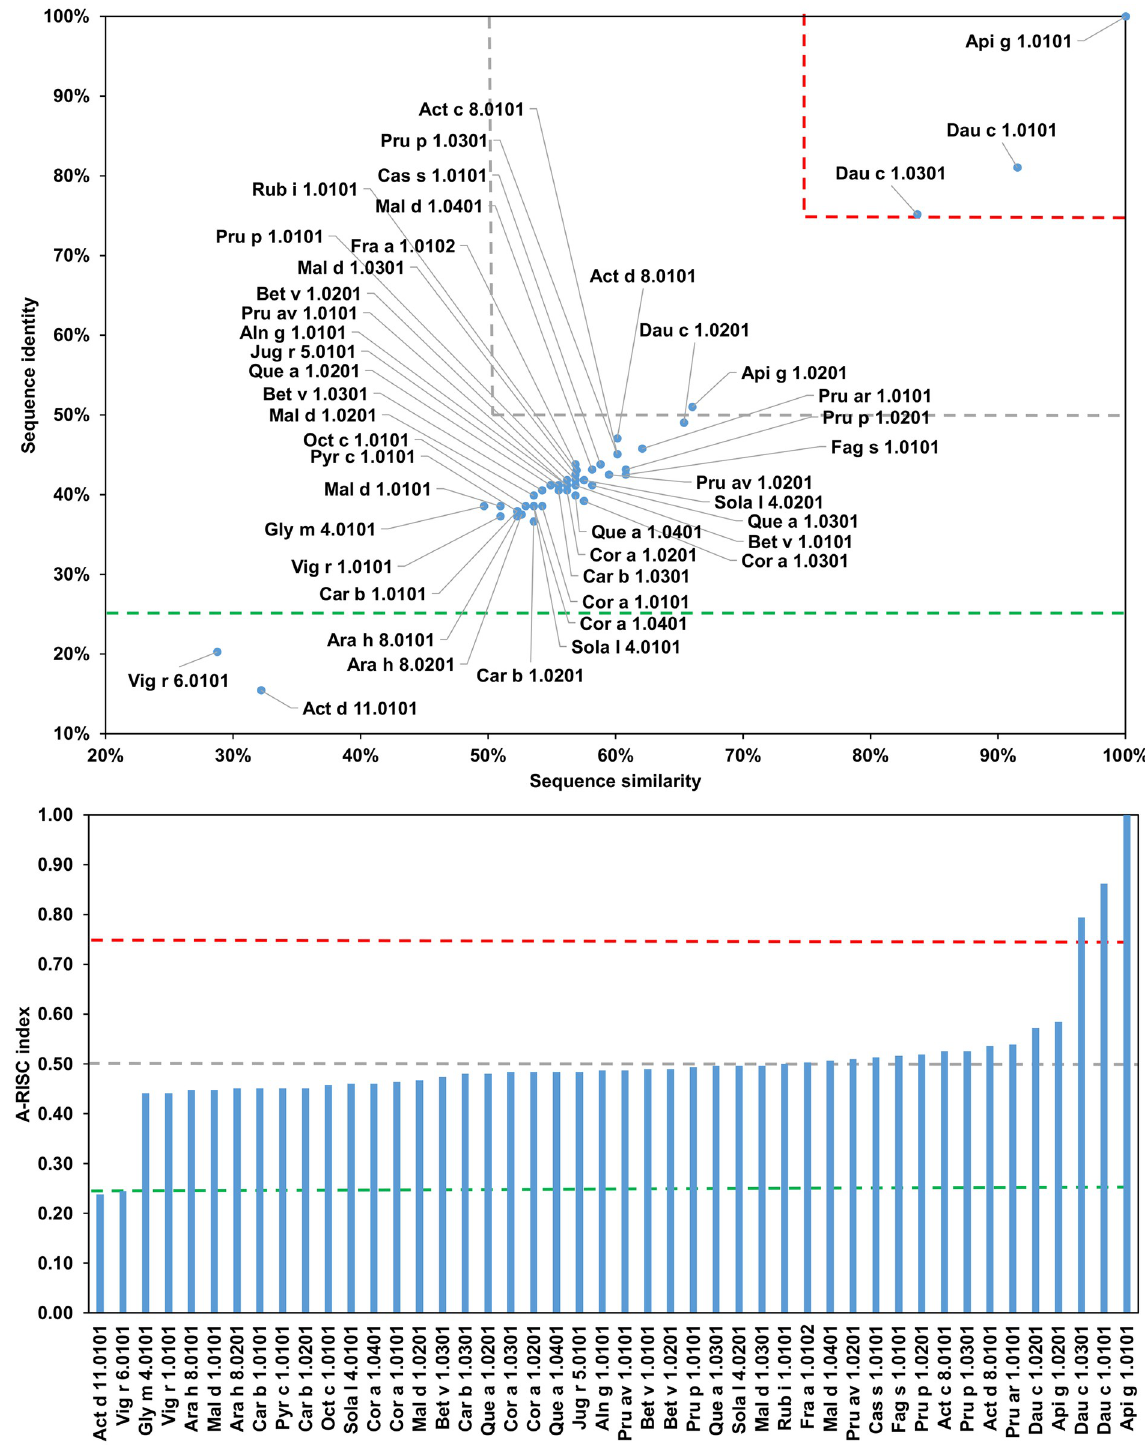
Fig 26. Plots showing relative homology and A-RISC indexes of allergens from PR-10 (Bet v 1-like) family. Comparison of the family members to Api g 1.0101. Red, gray, and dark green dashed lines indicate respectively 75%, 50% and 25% sequence identity and similarity, or 0.75, 0.50 and 0.25 A-RISC